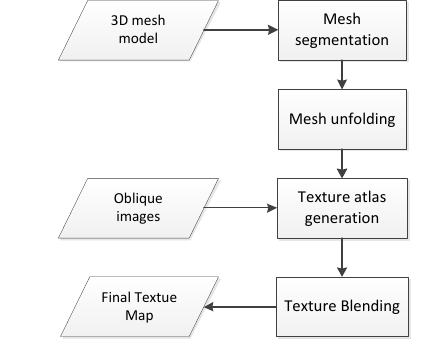
Fig.1. Whole flow of texture reconstruction from oblique